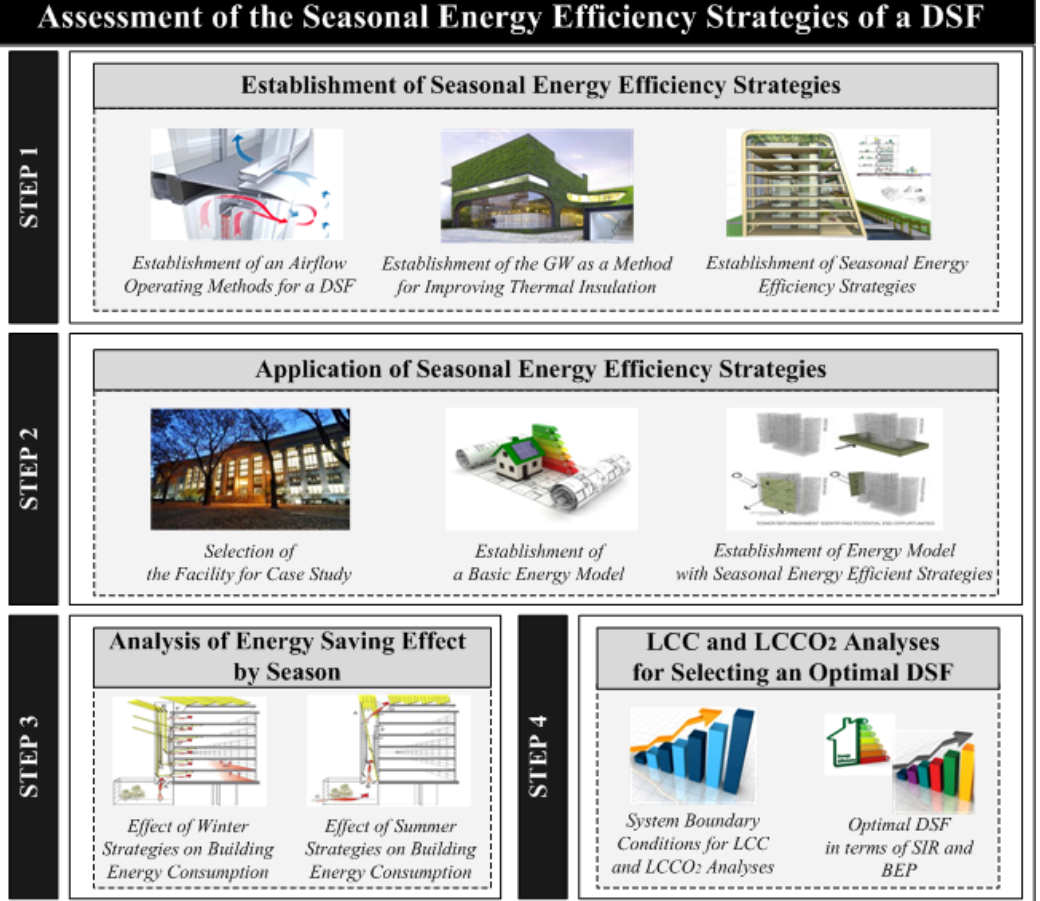
Figure 1. Research